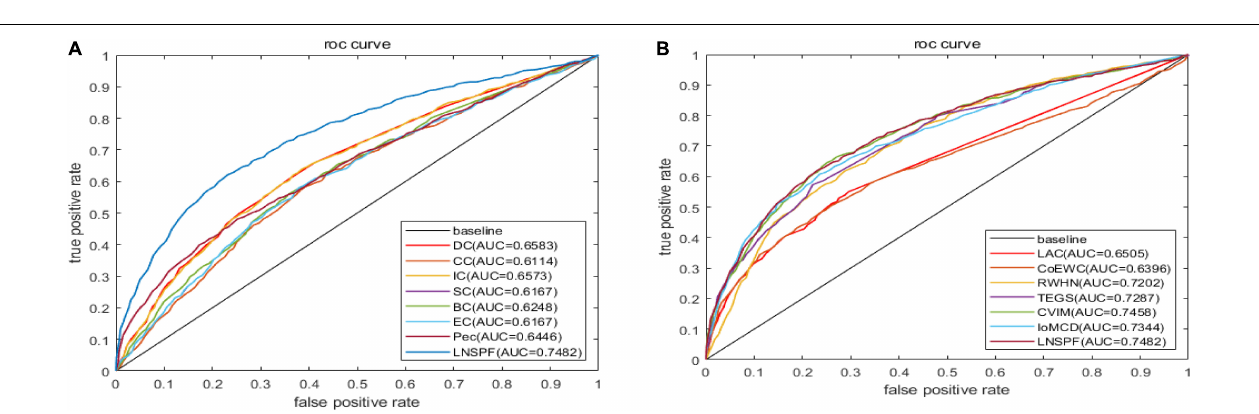
FIGURE 4 | The ROC curves of LNSPF method based on DIP dataset and DC, CC, IC, SC, BC, NC, Pec, and LAC CoEWC, POEM, ION, TEGS, IoMCD, and CVIM 14 prediction methods. (A) Comparison between LNSPF and DC, CC, IC, SC, BC, NC, PEC. (B) Comparison between LNSPF and LAC, CoEWC, POEM, ION, TEGS, IoMCD, CVIM.